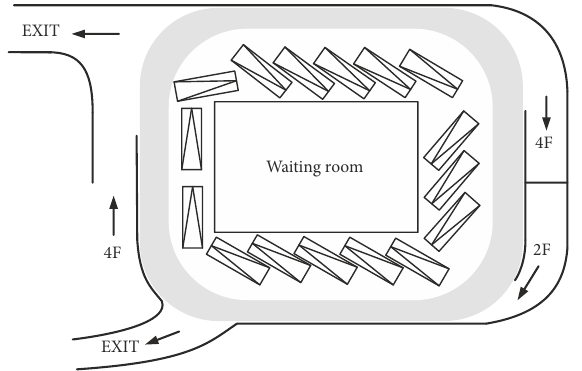
Figure 2. The third floor layout of the Taipei Bus Station